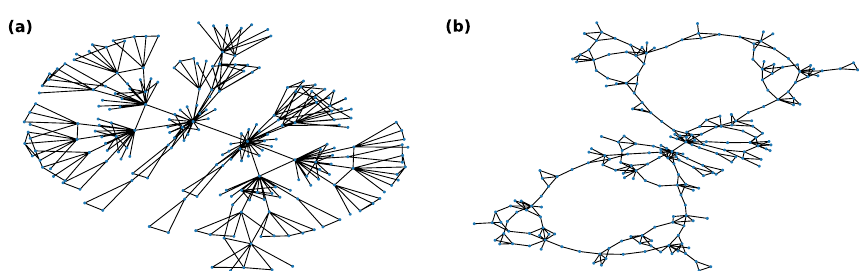
Fig. 4 Illustration of the Hub attraction dynamical growth model for a m = 2, a = 0, b = 0.1, T = 0.9 , b m = 2, a = 0, b = 1, T = 0.9 . In both cases, three iteration steps were made